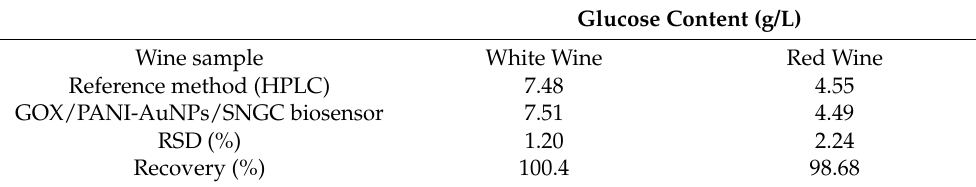
Table 3. Glucose content determined in two different wine samples (white and red wines) by using the GOX/PANI-AuNPs/SNGC biosensor in 0.1 M PBS (pH